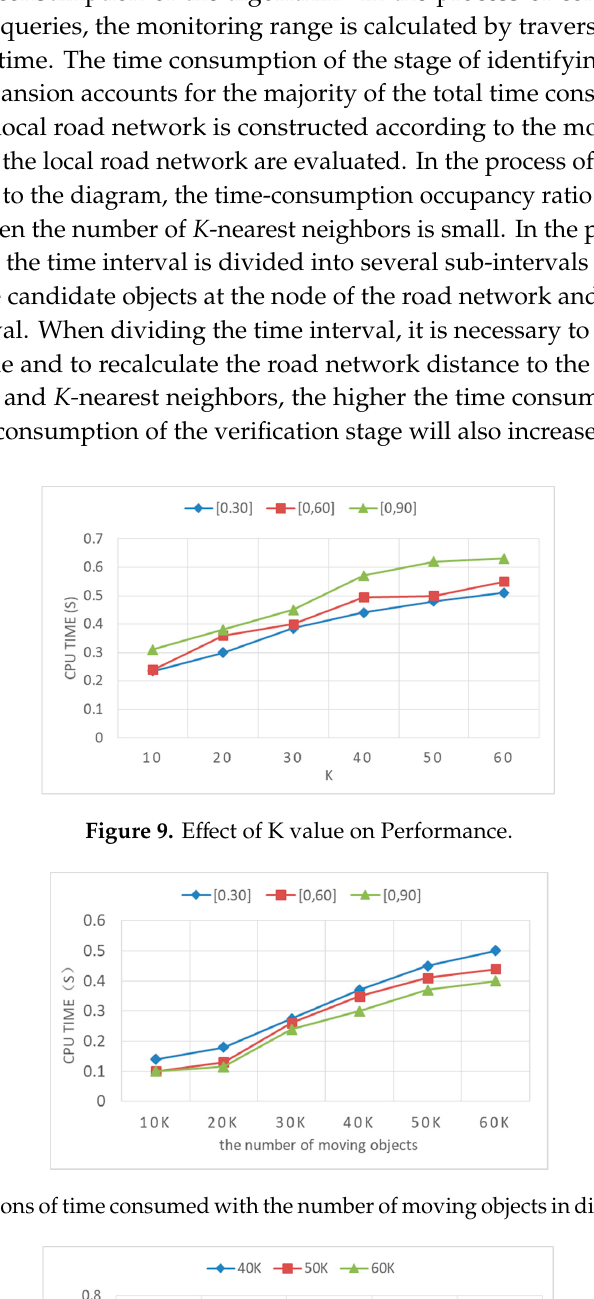
Figure 9. Comparisons of time consumed with the number of moving objects in different time Figure 12. The number of nodes, edges, and moving objects in local road network with different K intervals. values.